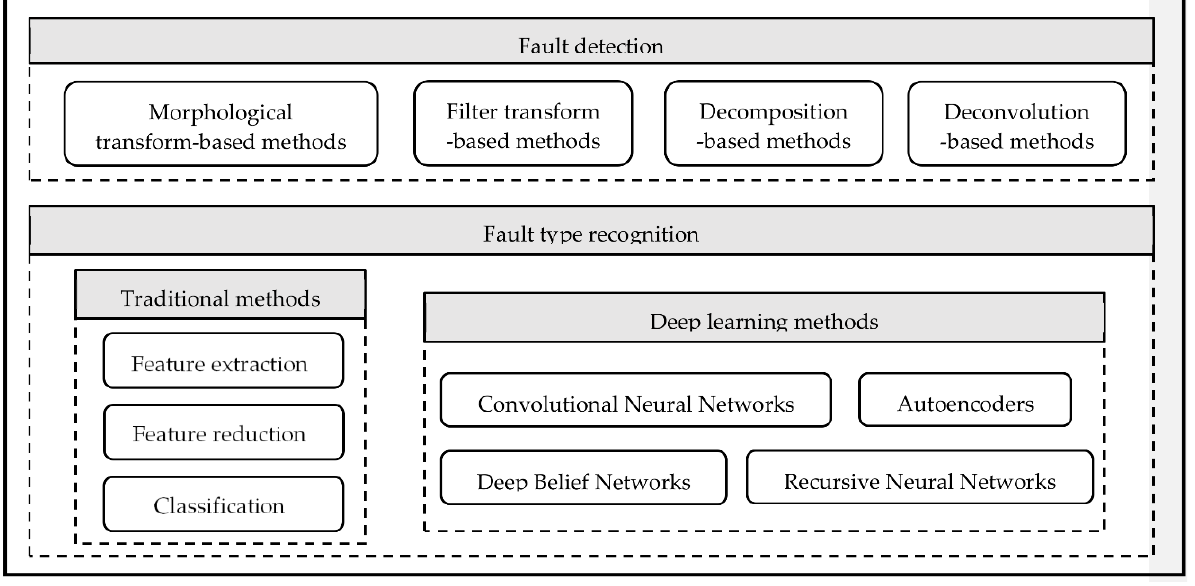
Figure 3. The taxonomy of this survey.